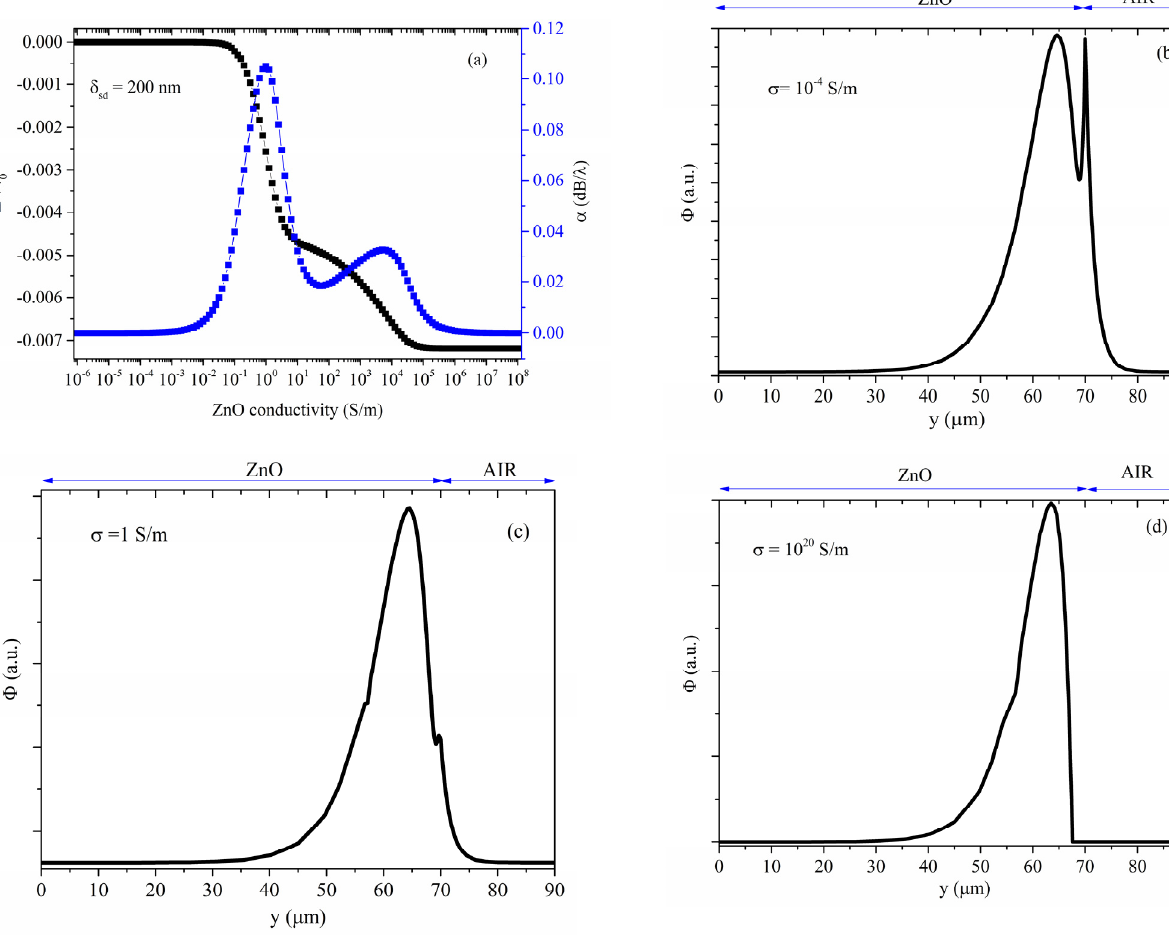
Figure 7. ( a ) Velocity and propagation loss vs. the ZnO conductivity curves; the electric potential profile for σ equal to ( b ) 0.0001, ( c ) 1, and ( d ) 10 20 S/m; all the plots refer to δ sd = 200 nm.